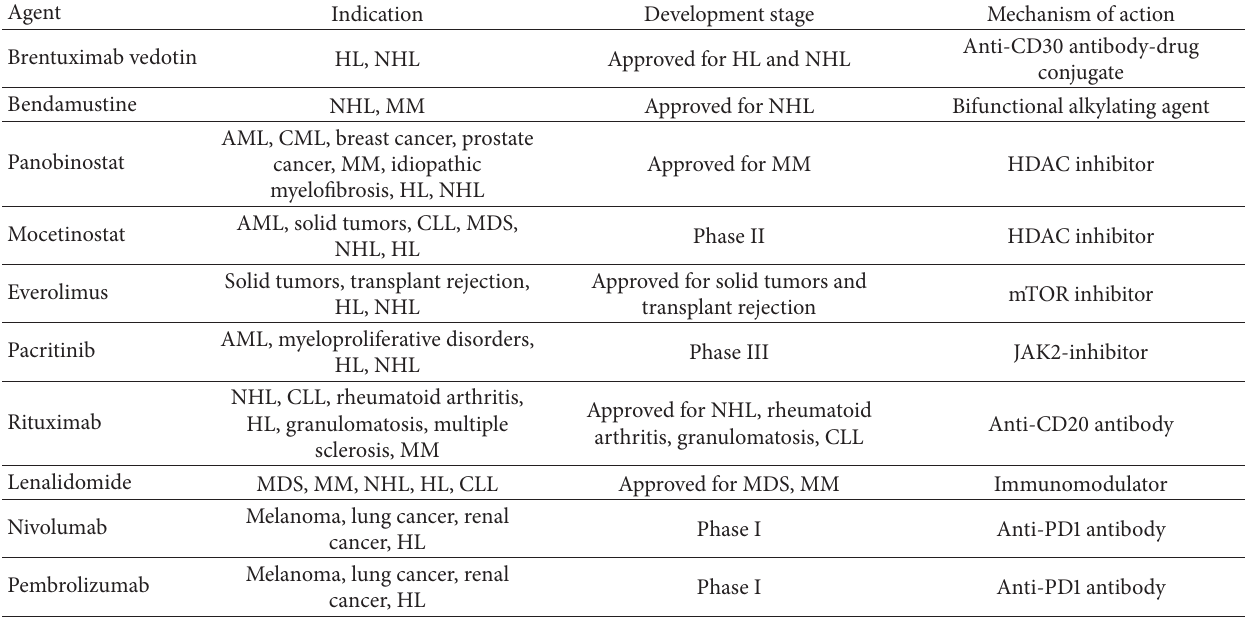
Table 2: Competitive